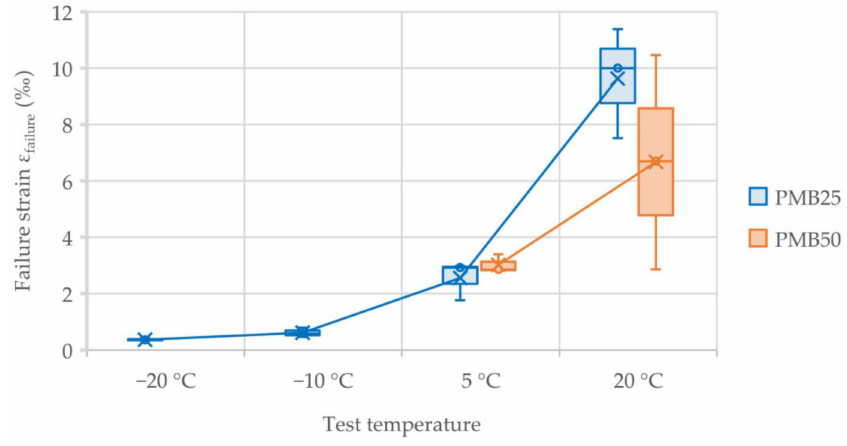
Figure 8. Failure strain results, ε failure , from the uniaxial tension stress test (UTST) for SMA 11 mixtures with PMB25 and PMB50.